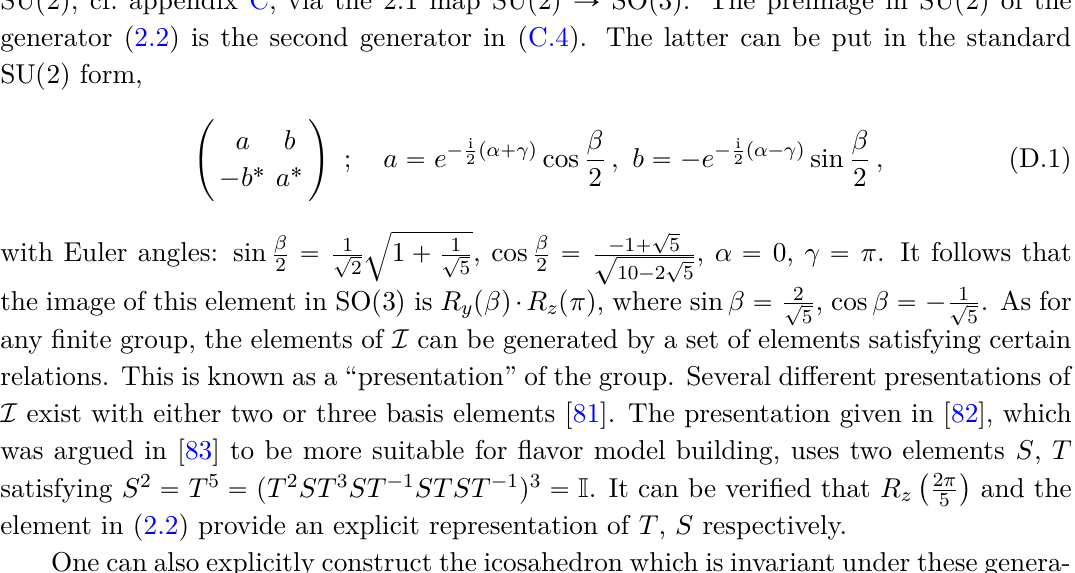
JHEP03(2022)169